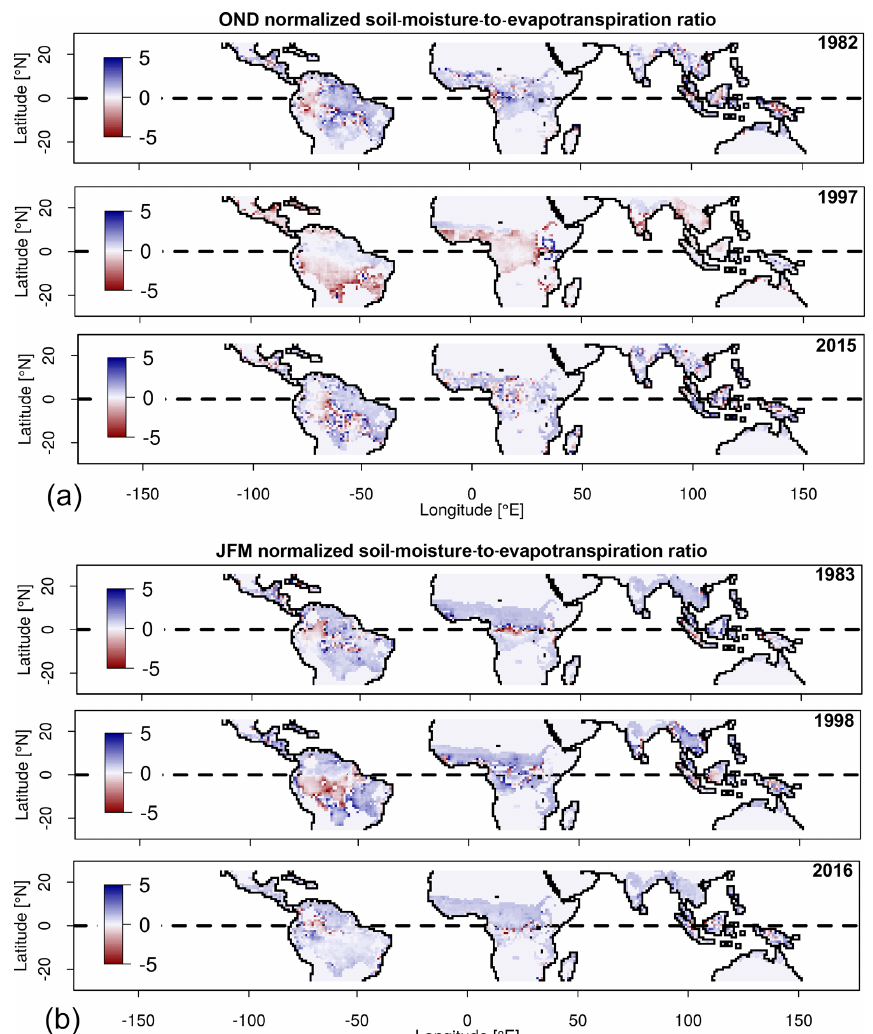
Figure 8. (a) Ratio of bias-corrected GLDAS soil-moisture-to-evapotranspiration change computed using October-to-December (OND) anomalies during El Niño years 1982–1983, 1997–1998 and 2015–2016 relative to previous years. Anomalies relative to the 1979–2016 period. (b) Same as (a) but for January to March in 1983, 1998 and 2016. Table 5. Mean and standard deviation of October-to-December (OND) and January-to-March (JFM) change in the soil-moisture-to- evapotranspiration ratio for the same regions shown in Table 3. Statistics computed using OND and JFM bias-corrected GLDAS soil